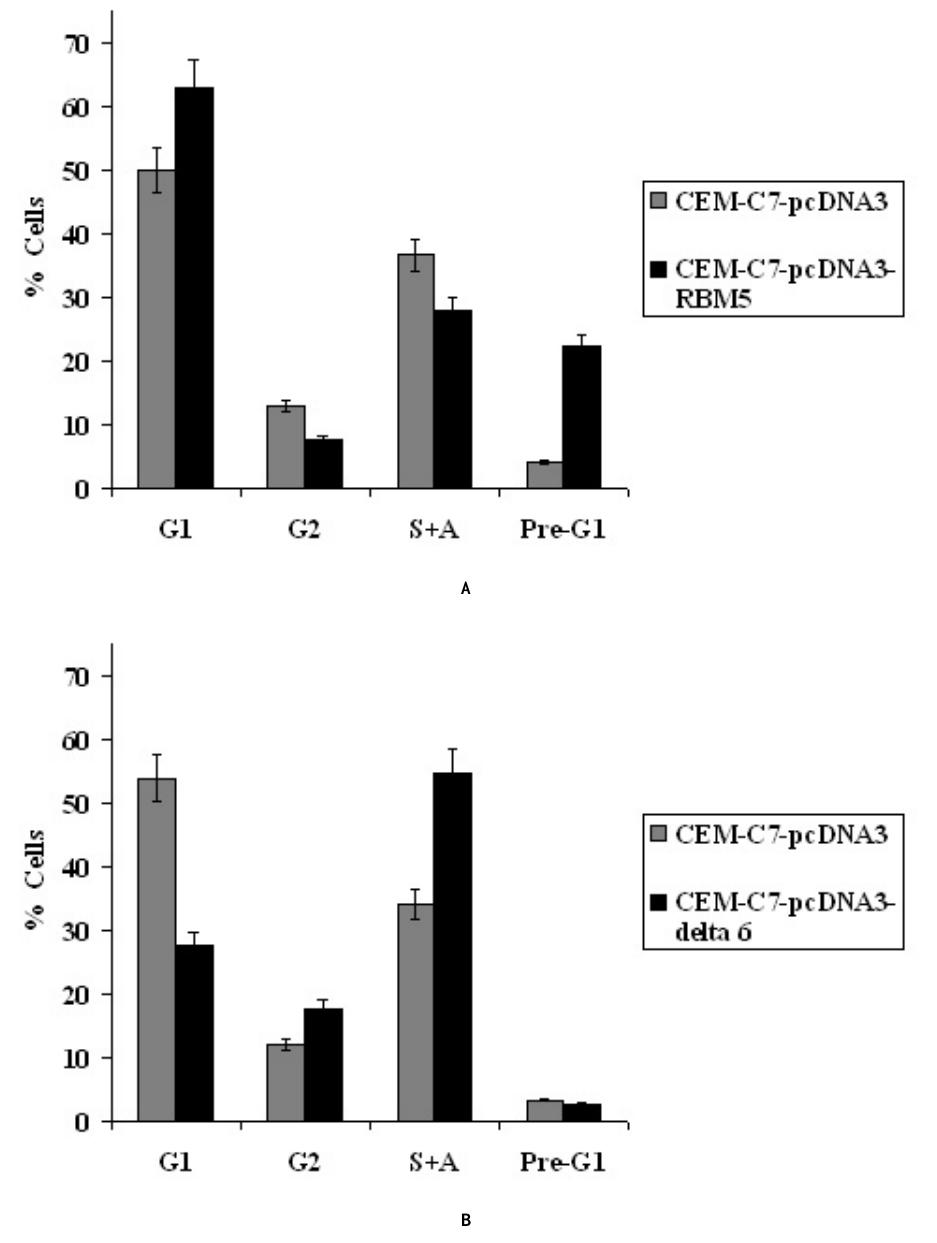
FIGURE 2 . (A) LUCA-15/RBM5 is capable of inducing cell cycle arrest in G 1 -M and apoptosis. DNA content from CEM-C7/pcDNA3 and CEM-C7/pcDNA3-RBM5 was quantified by propidium iodide staining of fixed cells. (B) LUCA-15 Δ 6 overexpression results in an increase in cells in S and G2/M phases, and a concomitant decrease in G1 cells, producing an increase in proliferation